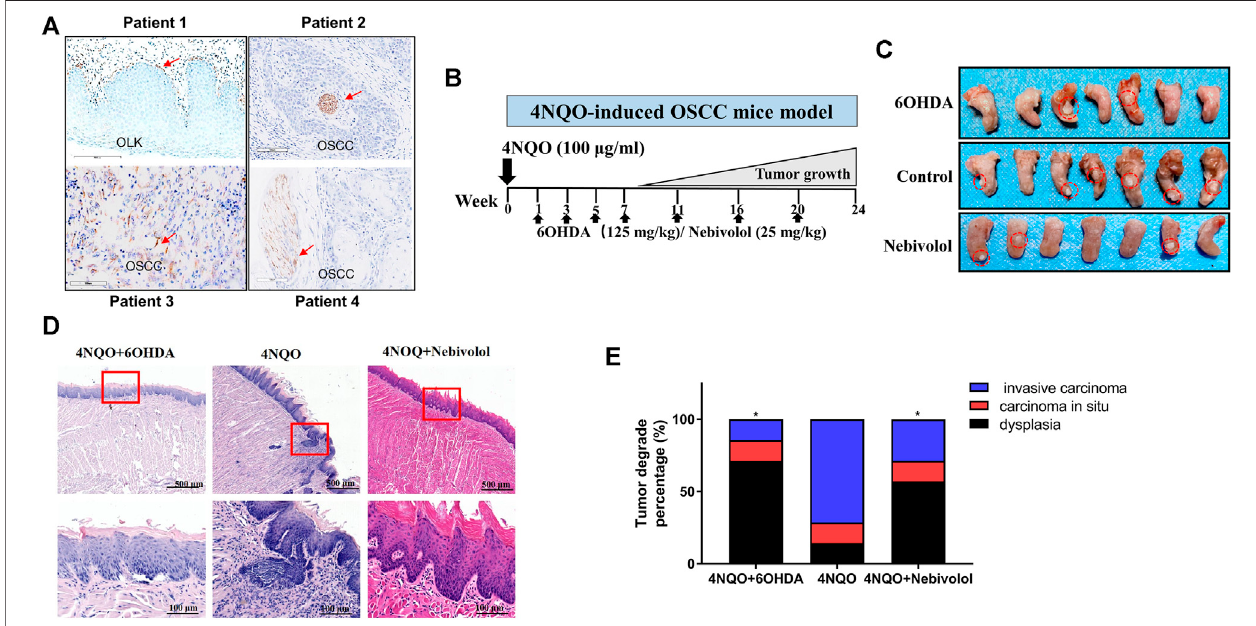
FIGURE 1 | The distribution of nerves in OSCC tissues and 6OHDA halted the growth of tumors in the 4NQO-induced tumor mice model. (A) The distribution of β - Ⅲ -tubulin protein in OLK and OSCC tissues. The red arrows showed the positive staining. (B) The pattern of 4NQO-induced tumor mice model. (C) Representative imagesof isolated 4NQO-induced tumors treated with vehicle or nebivolol or 6OHDA for 24 weeks. (D) Representative images of 4NQO-induced tumor in three groups in HE staining. The red boxes ’ images were magni fi ed at the bottom of the images. (E) The histopathological degrades of tumor lesions were analyzed. Data represent the mean ± SD of three replicate independent experiments. The asterisk (*) indicates a signi fi cant difference compared to the control group (* p < 0.05).